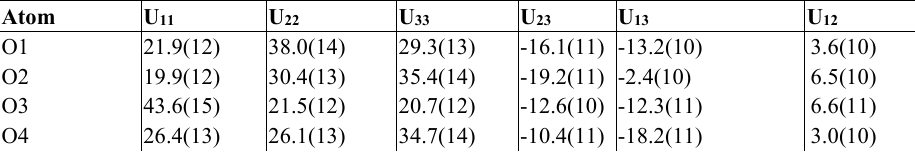
Table 3. Anisotropic Displacement Parameters (Å 2 ×10 3 ) for